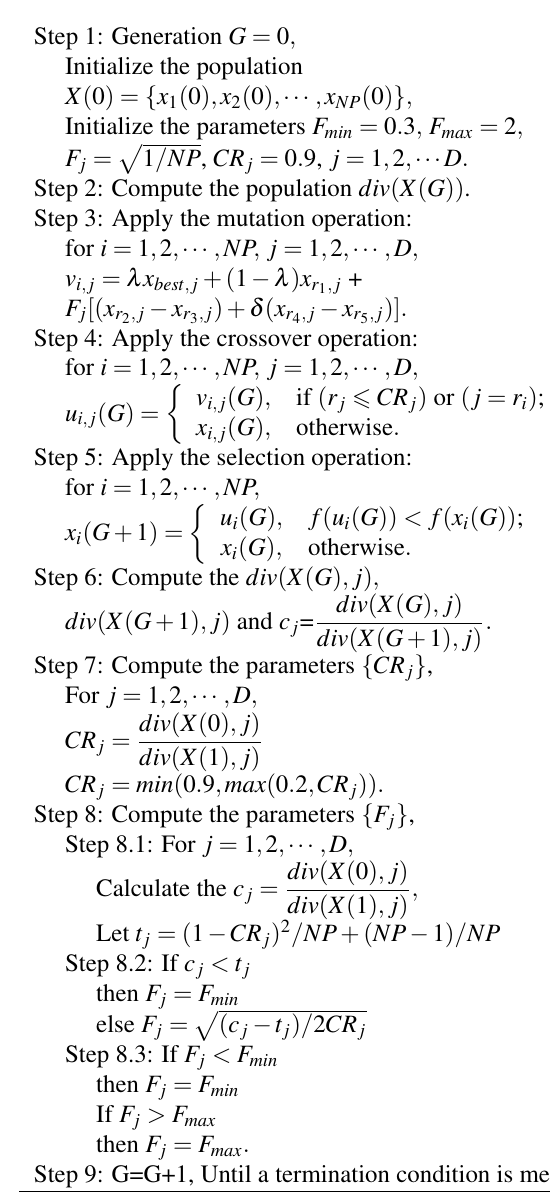
Step 1: Generation G = 0 , Initialize the